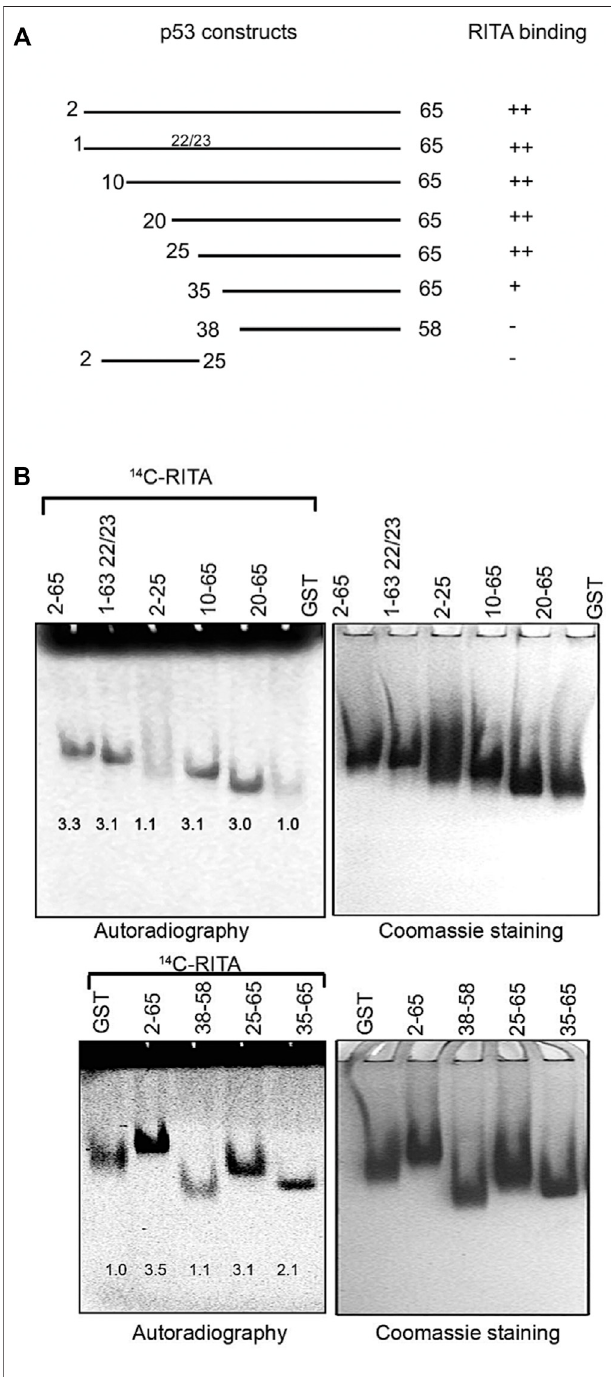
FIGURE 2 | RITA binding site is located between residues 25 – 38 of the human p53 N-terminus. (A) . Scheme depicting the series of deletion mutants generated to map RITA binding site. (B) [ 14 C]-RITA only binds to p53 N terminus deletion mutants containing residues 25 – 38. Band density in 8% TBE gels was measured using ImageJ software and normalized to